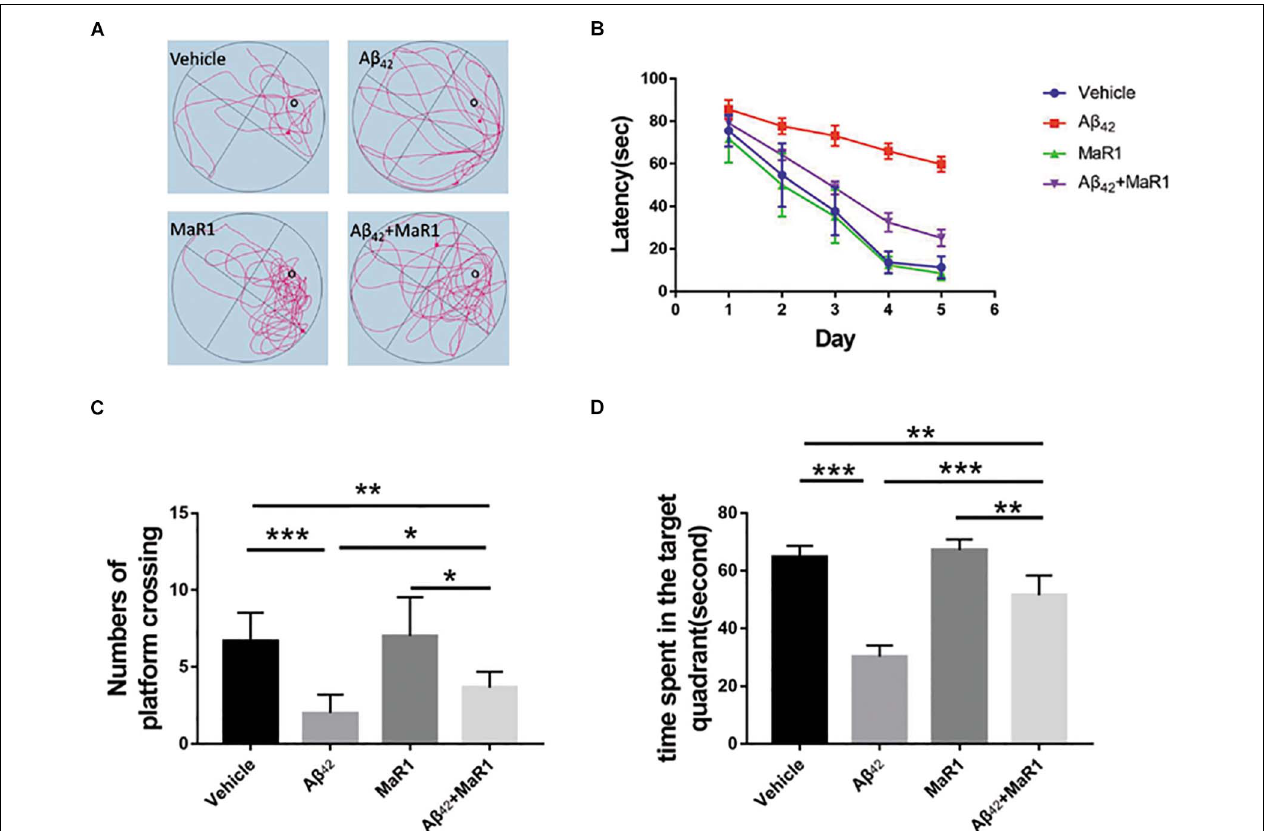
FIGURE 1 | MaR1 improved learning and memory deficits in A β 42 treated mice. (A) Typical swimming tracks of the four groups on the sixth day after drug treatment. (B) Escape latency gradually decreased with time in all the four groups. On the sixth day after drug treatment, A β 42 treatment group showed significantly increased escape latency compared to Vehicle group, however, A β 42 + MaR1 treatment reversed the changes induced by A β 42 ( P < 0.05). (C) Numbers of platform crossing on the sixth day after drug treatment in probe test. A β 42 treatment significantly decreased the number of platform crossing compared to Vehicle group, while A β 42 + MaR1 treatment attenuated the changes induced by A β 42 ( P < 0.05). (D) Time spent in the target quadrant in the probe test on the sixth day after drug treatment. A β 42 treatment significantly decreased the time spent in the target quadrant compared to Vehicle group, while A β 42 + MaR1 treatment attenuated the changes induced by A β 42 ( P < 0.001). Data are expressed as mean ± SEM, 10 mice in each group, and statistical significance is defined as follows: ∗ P < 0.05, ∗∗ P < 0.01, ∗∗∗ P <